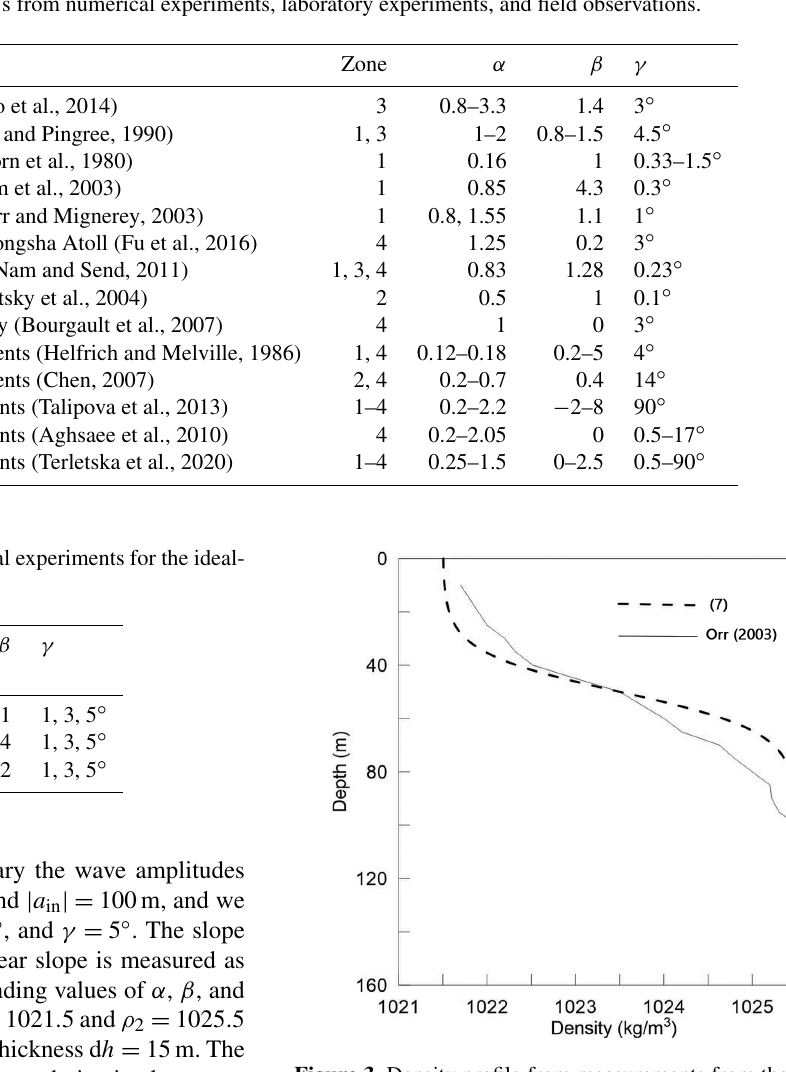
Figure 3. Density profile from measurements from the SCS (May) (Orr and Mignerey, 2003), and the initial density profile (Eq. 7) used for numerical